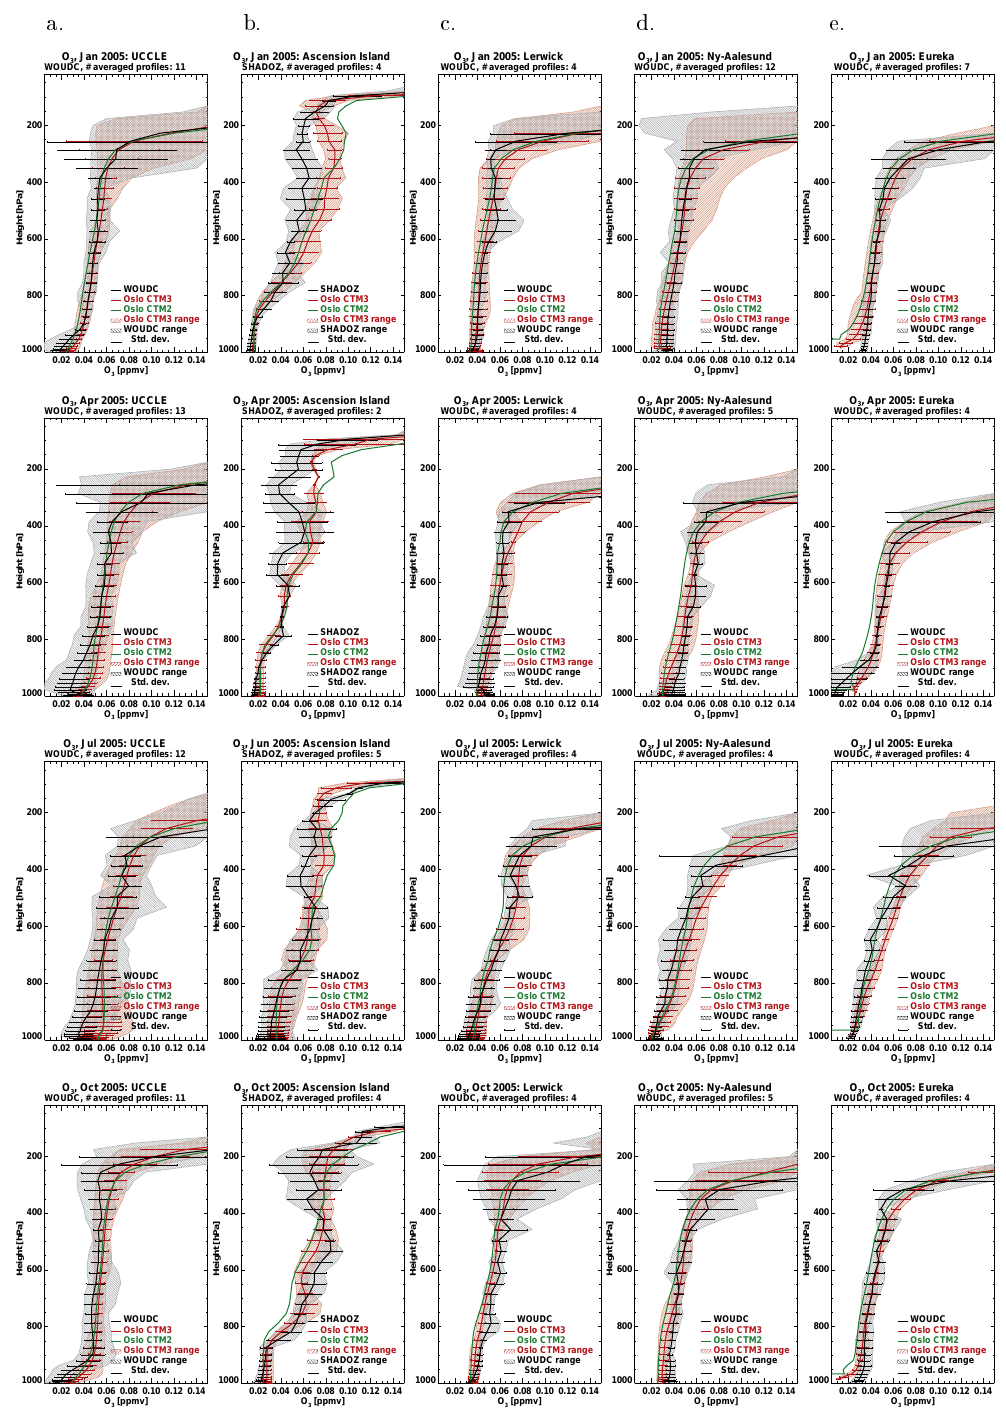
Fig. 10. Modelled (C3 ssn and C2 ssn) and measured monthly mean vertical profiles of O 3 at selected sonde stations (a–e) in 2005. Different months for each station are shown in columns. the model top (LTOP). The prior defines the tropopause at tial temperature and a somewhat arbitrary lower limit of 5 km potential vorticity of 2.5 PVU (Holton et al. (1995), 1 PVU (only occurs occasionally). For 2005, the fraction of air be- is 10 − 6 Km 2 kg − 1 s − 1 ), with an upper limit of 380 K poten- low the CTM tropopause is 80.2 %, while below 200 hPa